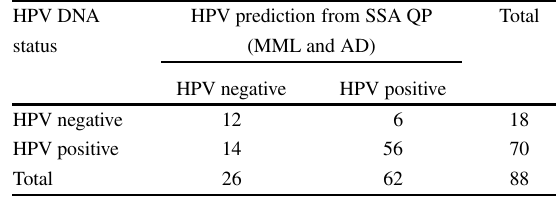
Confusion matrix, sensitivity, specificity, positive and negative pre- dictive value of consensus CIN grade and SSA quantitative pathol-